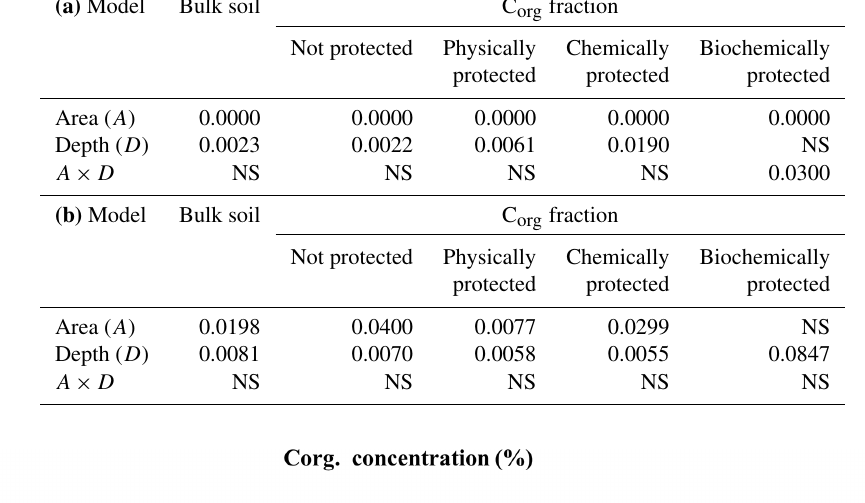
Table 2. Results of the two-way ANOVA of soil organic carbon concentration, C org (%), in different fractions and in bulk soil. In (a) area refers to the reference site vs. the olive orchard, and in (b) area refers to eroded vs. deposition areas in the olive orchard. NS stands for not significant.